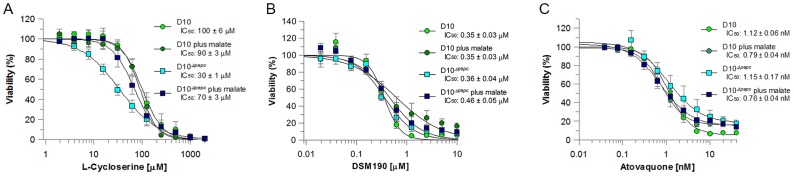
Efficacy of L-cycloserine, DSM190 and atovaquone against D10 and the D10Δ
pepc in routine and malate media.The effect of L-cycloserine (A), DSM190 (B) and atovaquone (C) on parasite viability. D10Δpepc was maintained for 9 days in routine medium prior to the experiment.